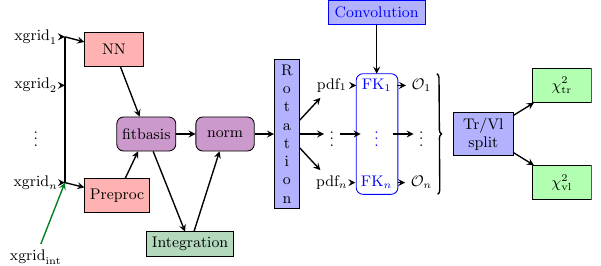
Fig. 1 Diagrammatic view of the n3fit code. Each different block is set as a different layer, following a structure similar to Keras. The red squared blocks correspond to blocks with fittable